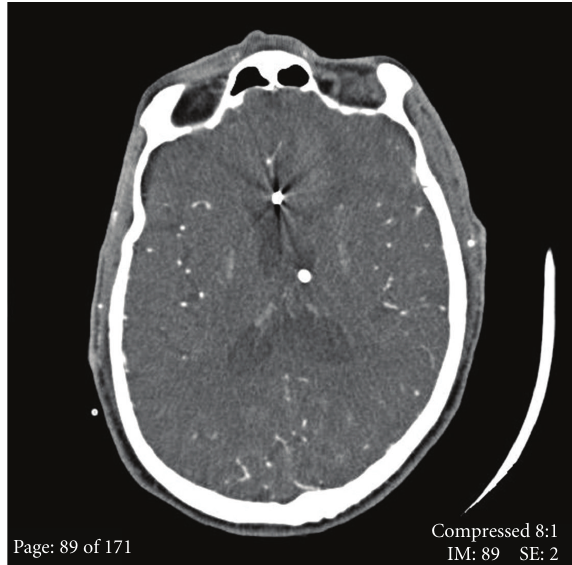
Figure 5: One week postoperative CT imaging demonstrating a metallic clip in the ACA, and a ventriculostomy in the lateral